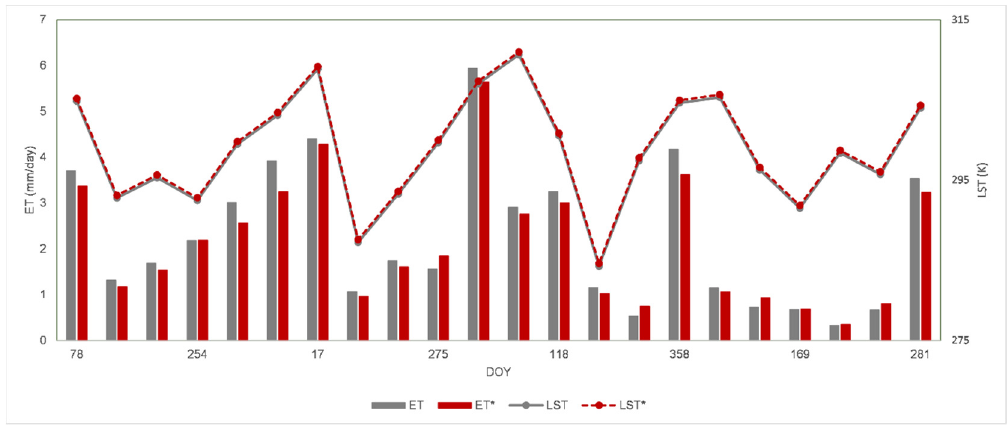
Figure 6. Grassland (in situ) daily evapotranspiration (mm/day) and Land Surface Temperature (K) with and without noise (*).